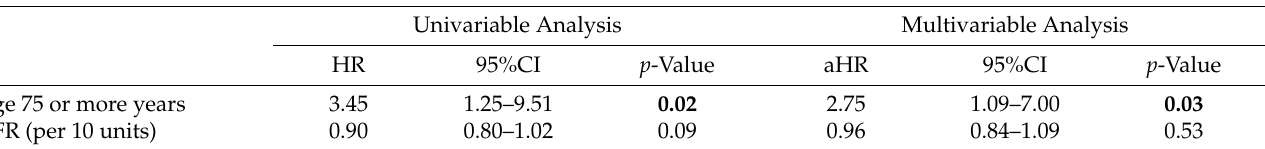
Univariable Analysis Multivariable